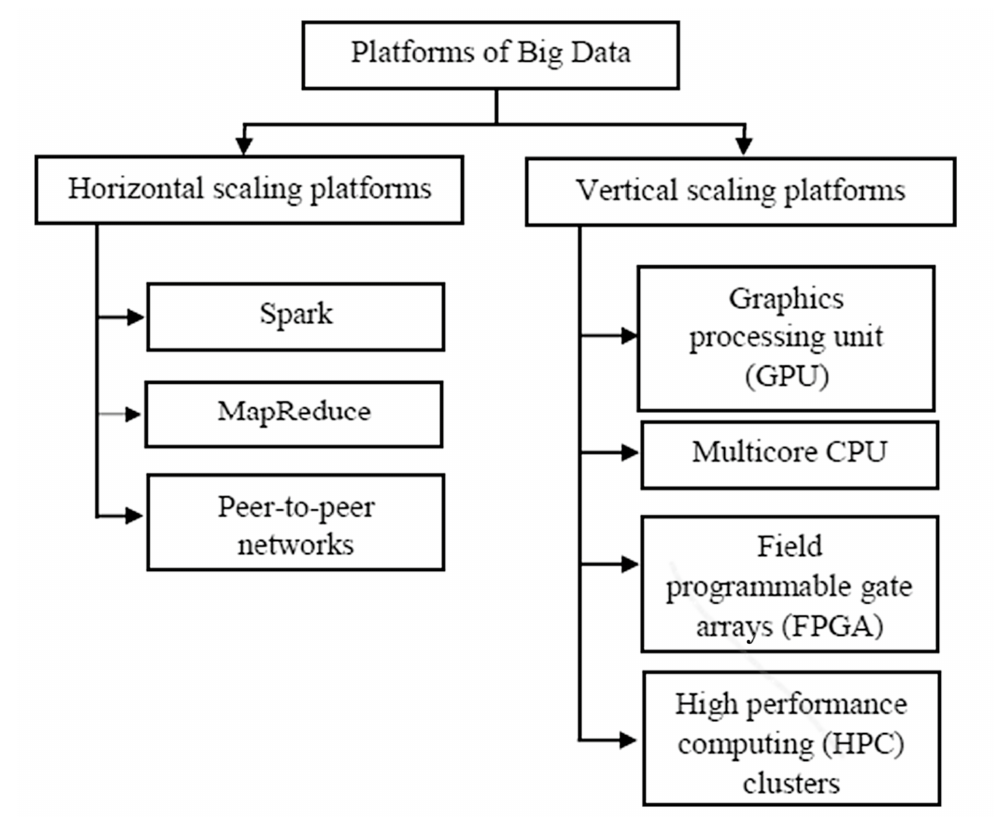
Figure 3. Big data platform. Spark